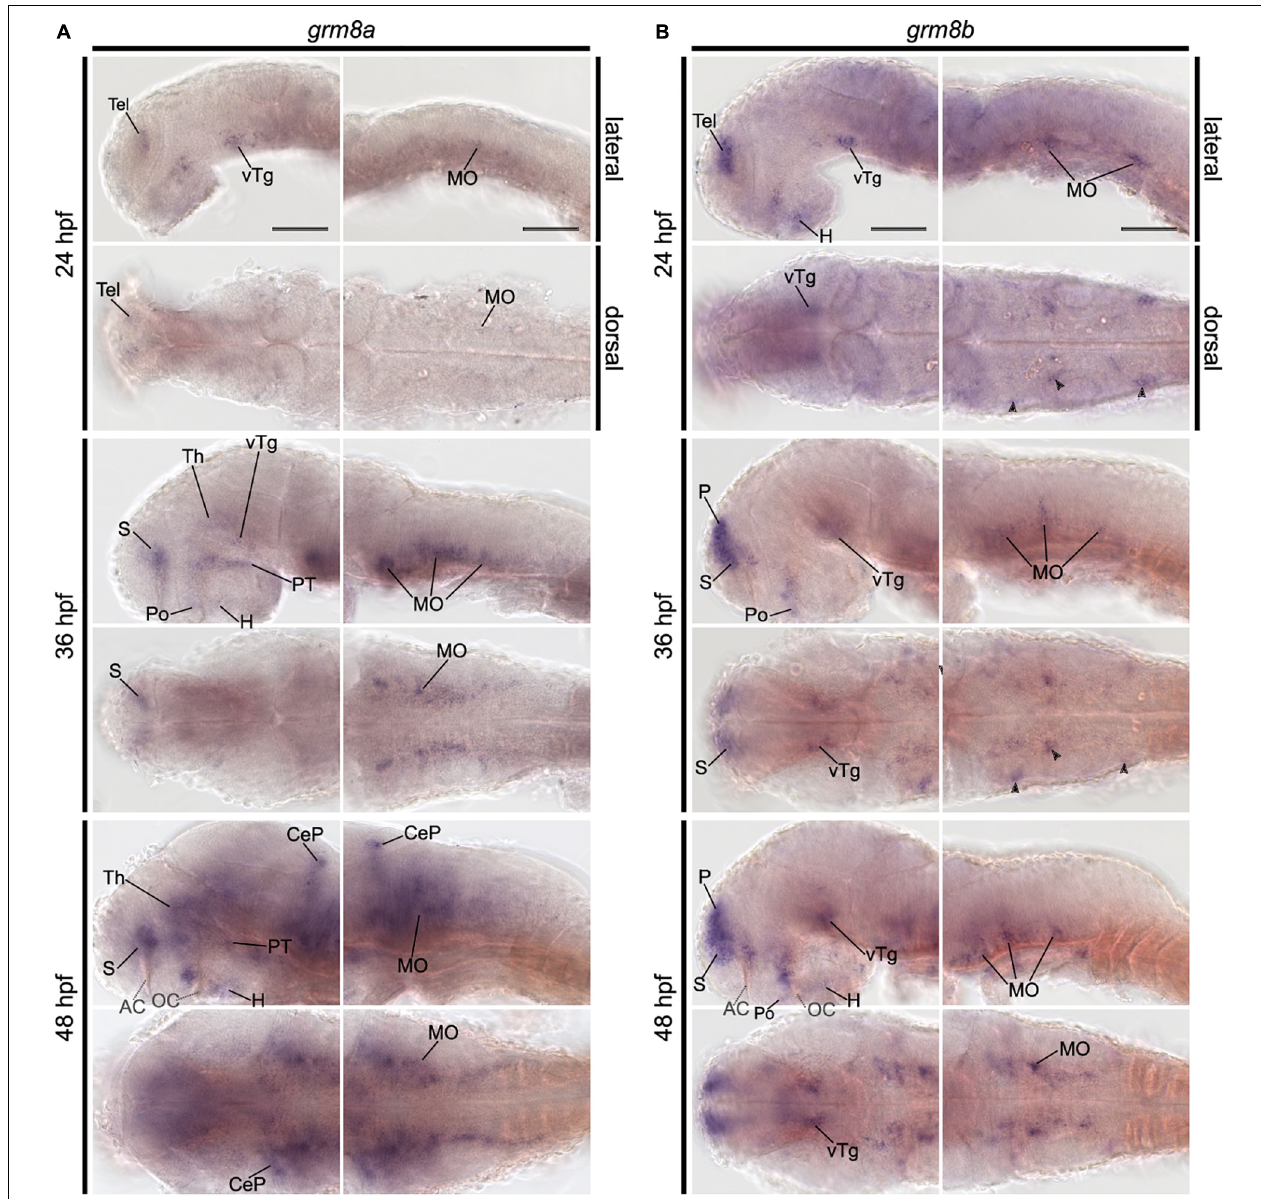
FIGURE 1 | Pattern of grm8a and grm8b expression in the developing zebrafish revealed by whole-mount RNA in situ hybridization. (A) Grm8a expression at 24, 36, and 48 hpf in the developing zebrafish. Lateral (top) and dorsal (bottom) overviews indicate expression as early as 24 hpf in the central nervous system. (B) Grm8b expression at 24, 36, and 48 hpf in the developing zebrafish. Lateral (top) and dorsal (bottom) overviews indicate prominent expression as early as 24 hpf in the central nervous system. Details on the individual expression patterns are described in the main text. Arrowheads indicate transcript labeling in individual cell cluster of the medulla oblongata (MO). All images are oriented with anterior to the left. Abbreviations are listed in Table 1 . Scale bar is 100 µ